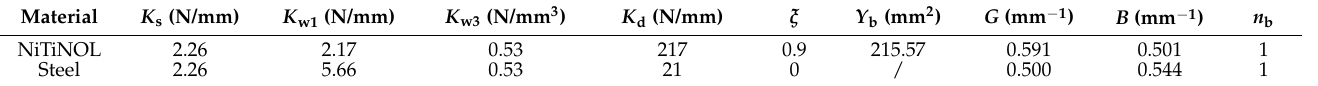
Table 1. Dimensional parameters of the isolators with a NiTiNOL wire rope and a steel wire rope. Material K s (N/mm)